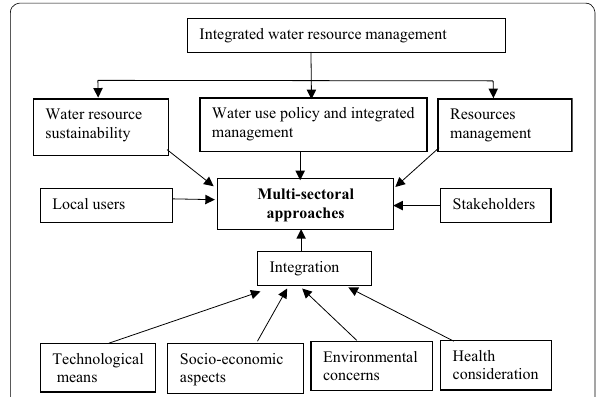
Fig. 3 Integrated waters resources management flow chart (After Al Radif